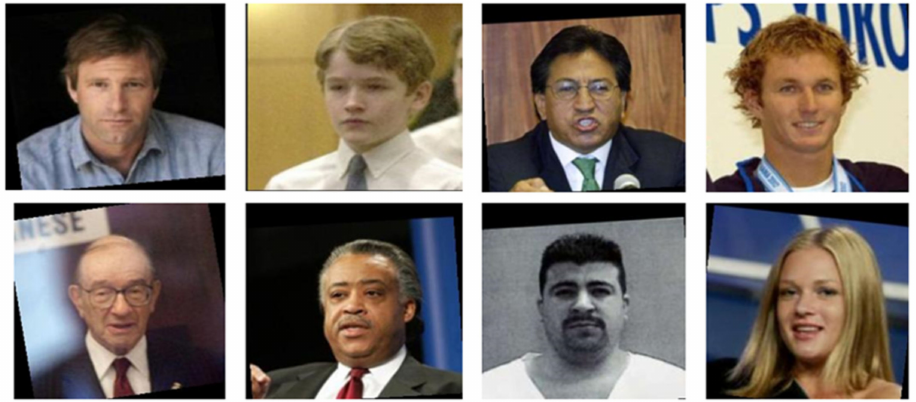
Figure 6. A few random samples from the LFW